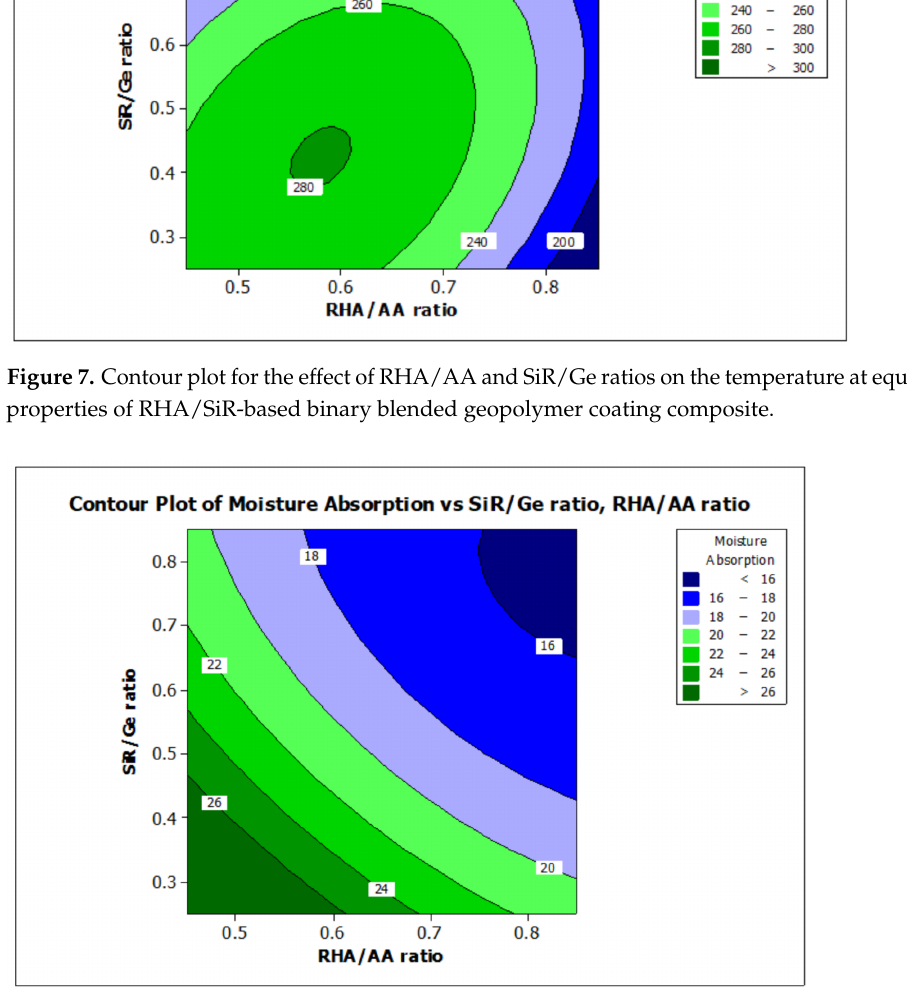
Figure 8. Contour plot for the effect of RHA/AA and SiR/Ge ratios on the moisture absorption properties of RHA/SiR-based binary blended geopolymer coating